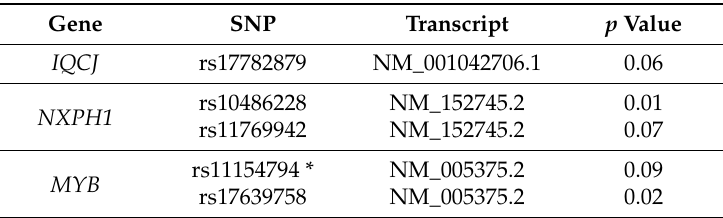
Table 3. Effects of genotype on the expression of transcripts associated with the IQCJ , NXPH1 , PHF17 and MYB genes ( n = 30 individuals).